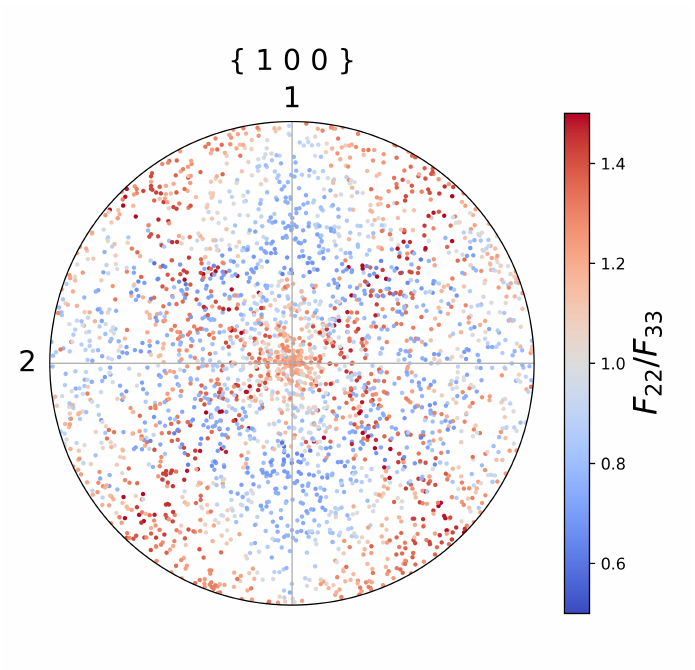
Figure 2. Distribution of the ratio of components F 22 to F 33 in the { 100 } pole figure under uni-axial traction when F 11 = 1.4. The positions of the points correspond to the randomly chosen Euler angles before deformations. The figure shows that the values of the ratio of F 22 to F 33 distribute differently when different initial Euler angles are chosen for the constitutive model.